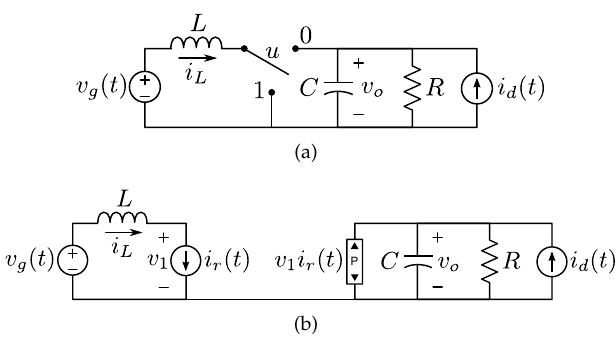
Figure 3. Schematic circuit diagram of ( a ) a Boost converter and ( b ) its ideal sliding-mode dynamics model under